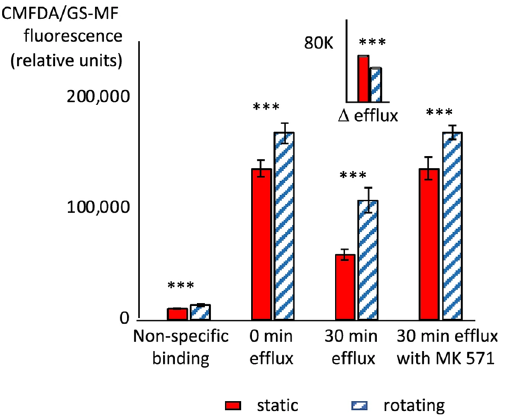
Figure 7. Effect of rotation in cell spinpods on the activity of xenobiotic efflux transporters. RPTEC/TERT1 cells on Cytodex carrier beads were cultured in cell spinpods under rotating ( ) or static conditions ( ) for 48 h and harvested. One aliquot of cells was chilled and cold CMFDA was added before immediate analysis to measure non-specific binding. The remaining cells were incubated with CMFDA for 40 min at 37 °C, washed, and the CMFDA/GM-SF was allowed to efflux in the presence and absence of the inhibitor MK571. The quantity of CMFDA/GS-MF in the cells was measured by flow cytometry immediately after washing (0 min efflux) and after 30 min of efflux at 37 °C (30 min efflux and 30 min efflux with MK 571). Asterisks indicate where differences in the distributions between groups were statistically significant, e.g. p < 0.05, by one-tailed Mann–Whitney U test. Non-specific binding was significantly higher in cells from rotating cell spinpods ( p = 0.00015, W = 2, n 1 = n 2 = 5). CMFDA/GS-MF remaining in cells from rotating cell spinpods was significantly lower at time zero ( W = 4, n 1 = n 2 = 6, p = 0.013), after 30 min of efflux ( p = 0.00035, W = 0, n 1 = n 2 = 5), and after 30 min of efflux in the presence of MK571 ( p = 0.065, W = 6, n 1 = n 2 = 6). The inset shows the difference in CMFDA/GM-SF signal between time 0 and after 30 min of efflux. The loss of CMFDA/GM-SF from cells in rotating cell spinpods was significantly larger ( p = 0.008, W = 24, n 1 = n 2 = 5).